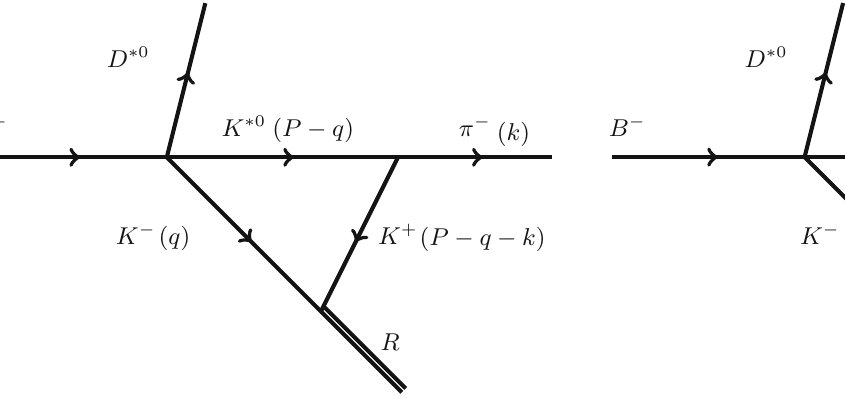
Fig. 1 Diagram for the decay of B − into D ∗ 0 , π − and R , where R = a 0 ( 980 ) or f 0 ( 980 )